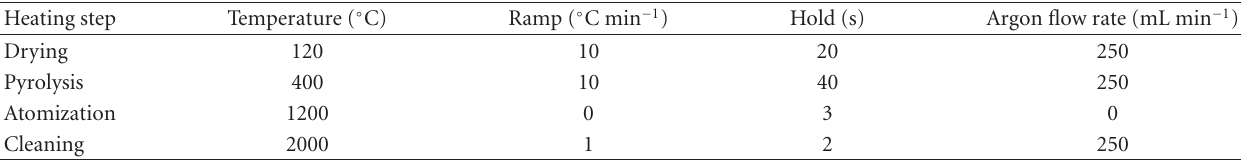
Table 1: Operating parameters for ETAAS determination of